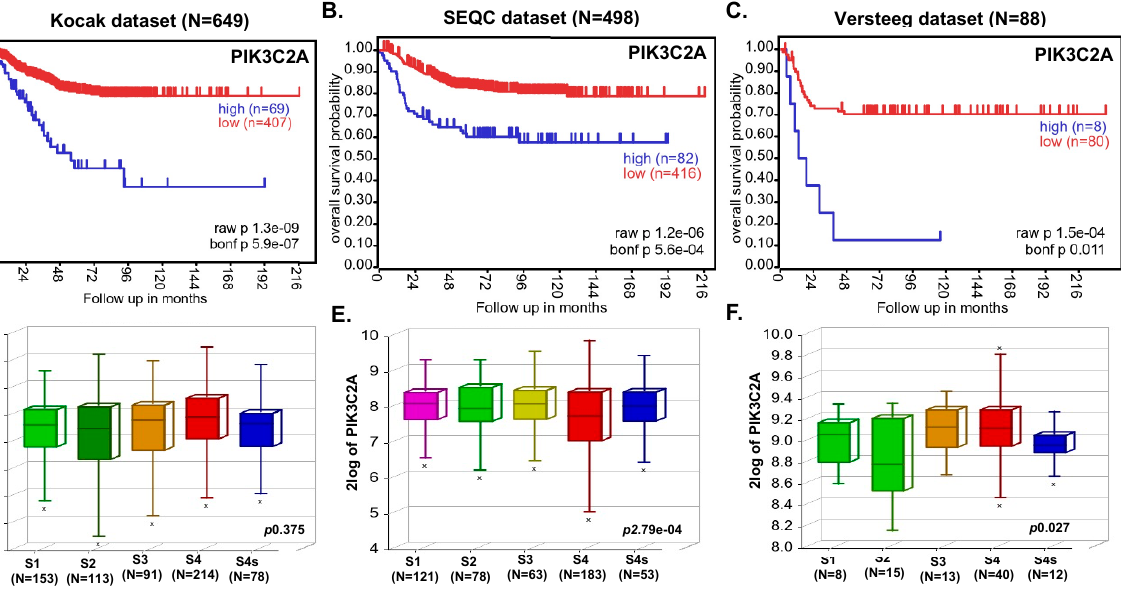
Figure 3. CUDC ‐ 907 inhibits NB colony formation and growth. Colony formation assays in response to CUDC ‐ 907 in four NB cell lines. ( A ) Representative images of colony formation assays in MYCN ‐ amplified cell lines NGP and LAN ‐ 5, and MYCN non ‐ amplified cell lines SH ‐ SY ‐ 5Y and SK ‐ N ‐ AS in response to CUDC ‐ 907 treatment. Cells were treated with CUDC ‐ 907 for 48 h. ( B ) Survival index graphs showing the quantitation of the relative inhibition of colony formation in the respective cell lines in response to CUDC ‐ 907 treatment. Colony numbers are normalized to control. *** p < 0.001, **** p < 0.0001. 3.3. CUDC ‐ 907 Induces Apoptosis and Blocks Cell Cycle Progression in NB Next, we performed apoptosis and cell cycle assays using different NB cell lines in response to CUDC ‐ 907. The results show that CUDC ‐ 907 significantly and in a dose ‐ dependent manner induces apoptosis in both NGP and SH ‐ SY5Y NB cell lines (Figure 4A, B). Specifically, CUDC ‐ 907 treatment increases the percentage of early apoptotic cells by 1.45 ‐ and 1.74 ‐ fold in SH ‐ SY5Y cells, and 1.46 ‐ and 1.86 ‐ fold in NGP cells, in response to 0.5 μ M and 1 μ M, respectively, and in contrast to control treatment (Figure 4A, B). Furthermore, we observed that CUDC ‐ 907 treatment significantly inhibits NB cell cycle progression by inhibiting the S phase (Figure 4C). In response to CUDC ‐ 907 treatment, the percentage of cells in the S phase decreased by 0.88 ‐ and 0.62 ‐ fold ( p < 0.05), while the percentage of cells in the G2/M phase increased by 1.6 ‐ and 1.7 ‐ fold ( p < 0.05),